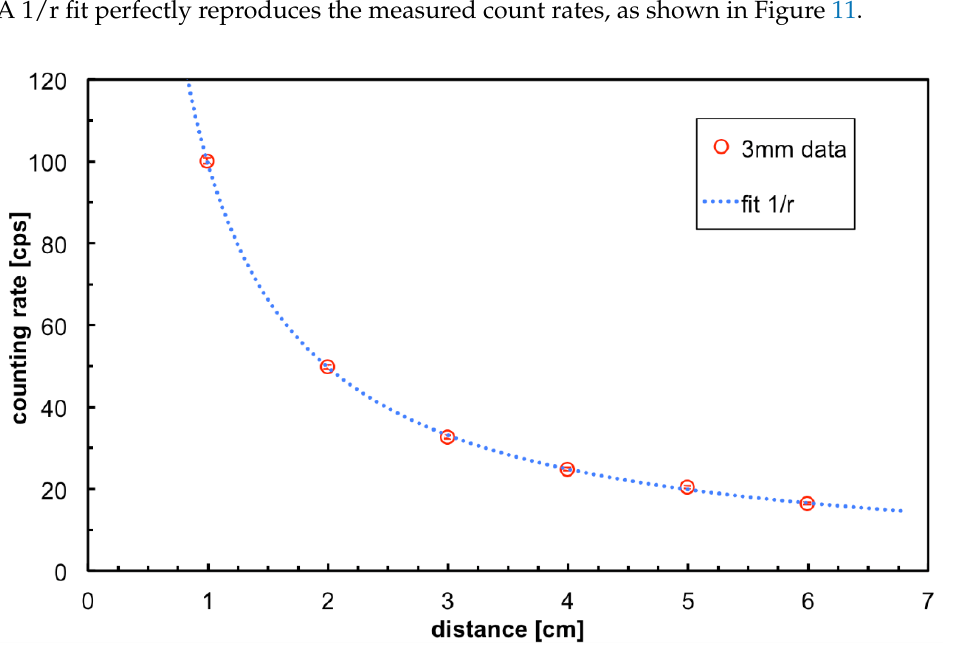
9 of 20 Figure 10. Sketch of the electronic setup for the SciFi detector. 3.1. Point-Like Source at Short Distance